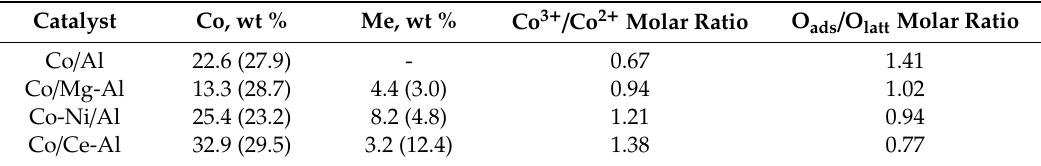
Table 2. Surface composition of the supported cobalt